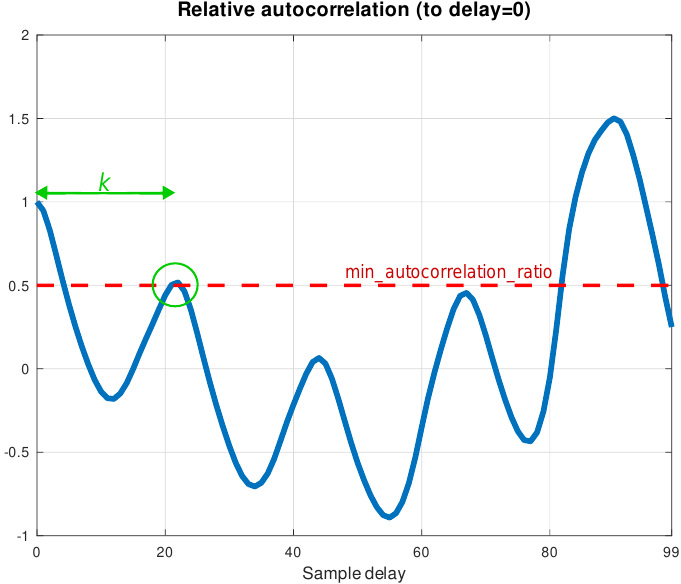
Figure 3. Autocorrelation of PPG signal for different delays. The shift k corresponding to the index of the closest local maximum matches the number of samples containing a complete heart beat. This peak, marked in Figure 3 by green, is sufficient to determine PPG signal periodicity. Therefore, pulse period T HR is calculated multiplying the number of samples k by the time gap between two samples, that is, sample period T s . This way, the heart rate is the inverse of the pulse period, represented in Equation